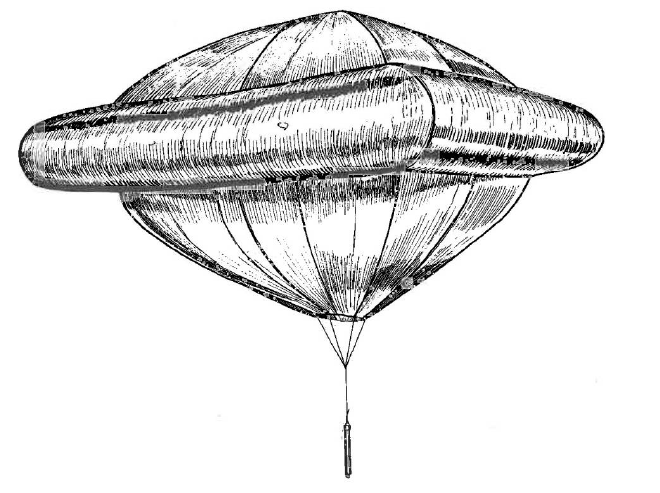
Figure 1. Drawing of an inflated starute with the torus-like bulky ring (“burble fence”) which stabilizes the flight and suppresses pen- dulum motion (from Bollermann, 1970).